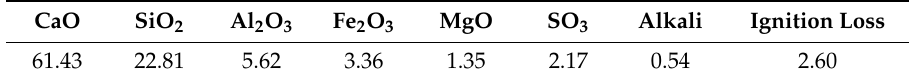
Table 7. The chemical compositions of Portland cement (%).